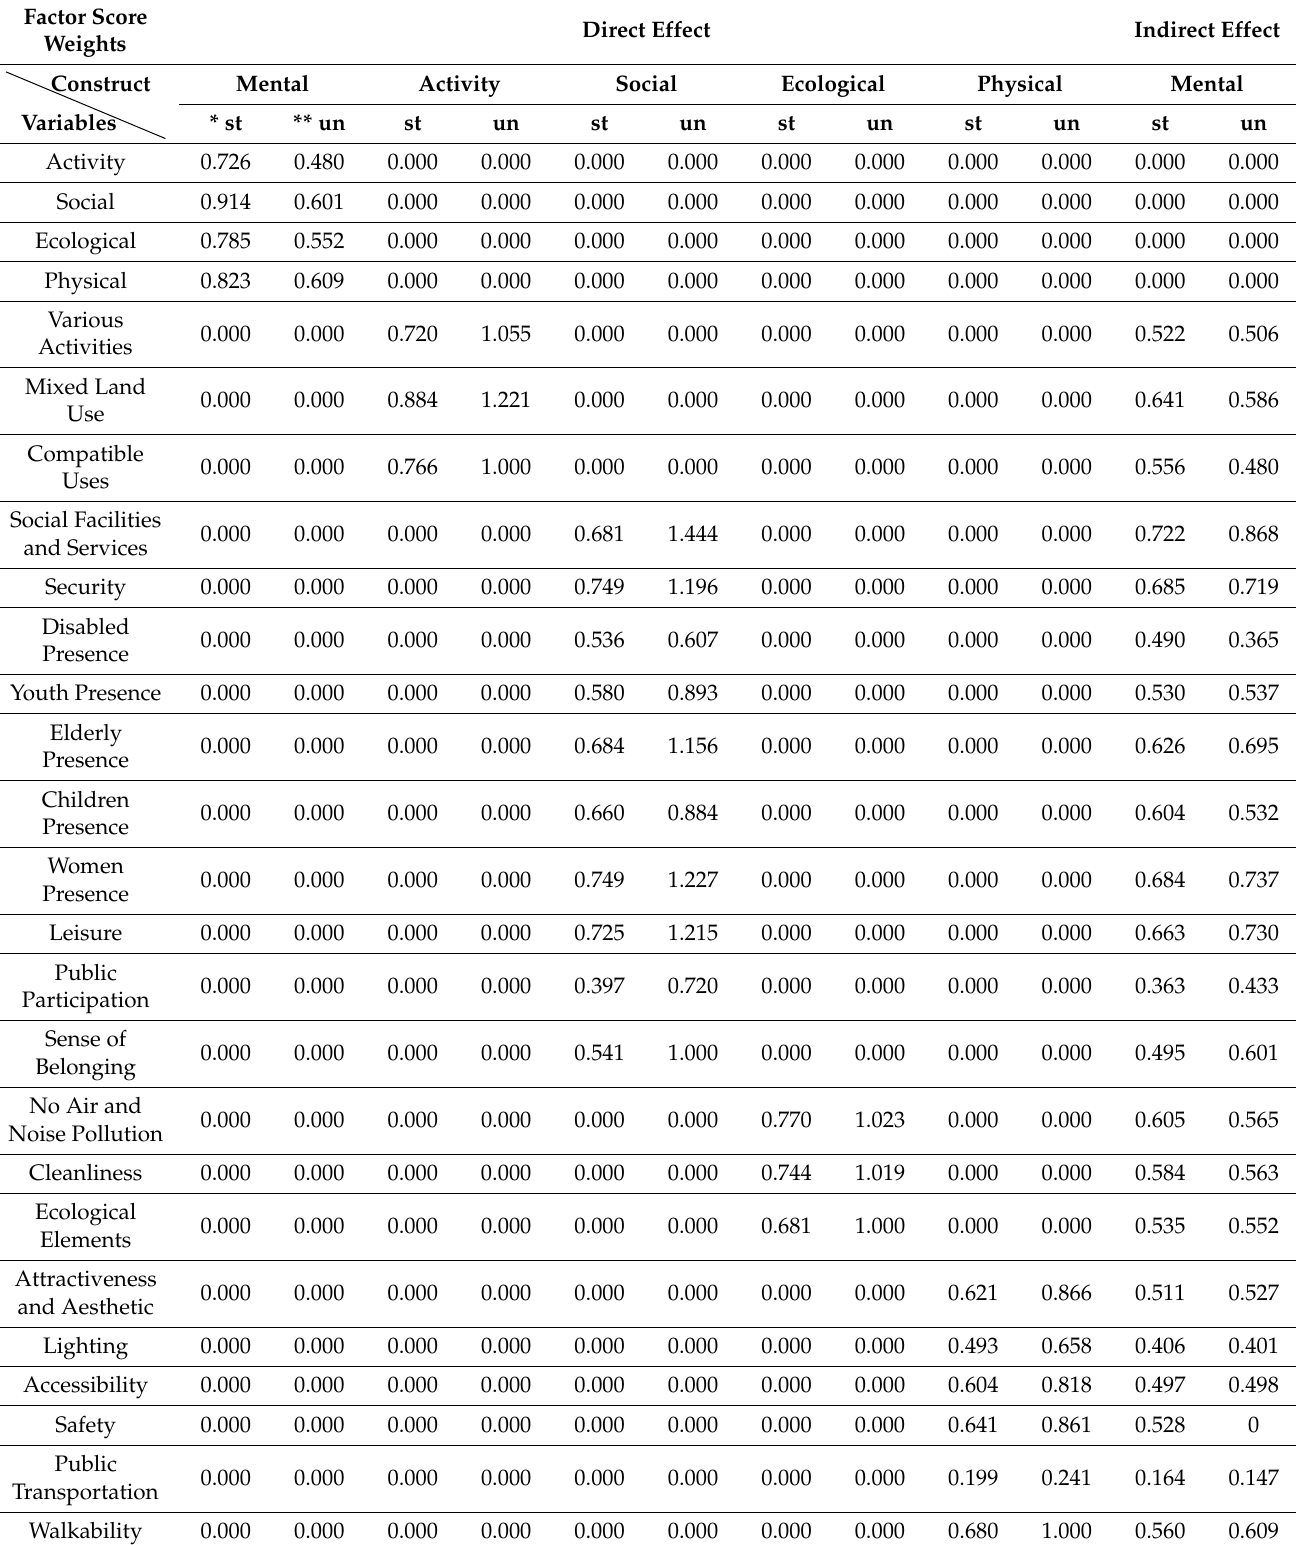
Table 7. Factor score weights: direct and indirect